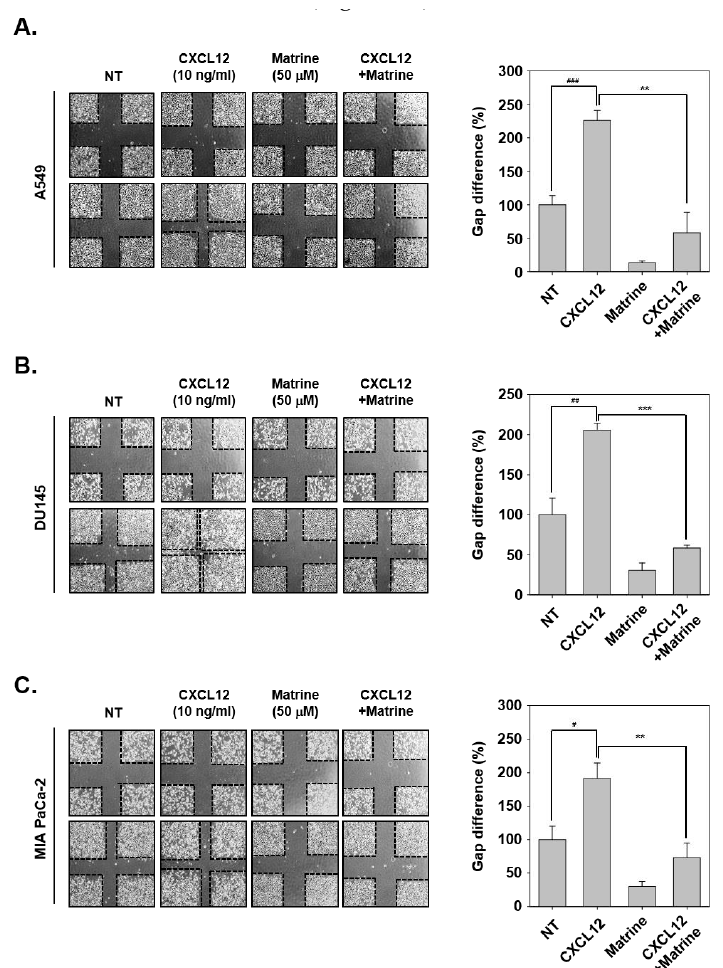
Figure 2. Matrine inhibits the cell migration on A549, DU145, and MIA PaCa-2 cells. ( A – C ) A549, DU145, and MIA PaCa-2 cells (5 × 10 5 cells / well) were seeded on 6 well plate. Wound healing assay was performed on each well, cells were scarred then CXCL12 (10 ng / mL) and matrine (50 µ M) were treated in serum-free media for 24 h. We observed conditions at 0 h, and compared with cell conditions at 24 h. All experiments were performed independently at least three times and representative data are shown. ### p < 0.001, ## p < 0.01, # p < 0.05 vs. non-treated (NT) cells and *** p < 0.001, ** p < 0.01 vs. CXCL12 + matrine treated